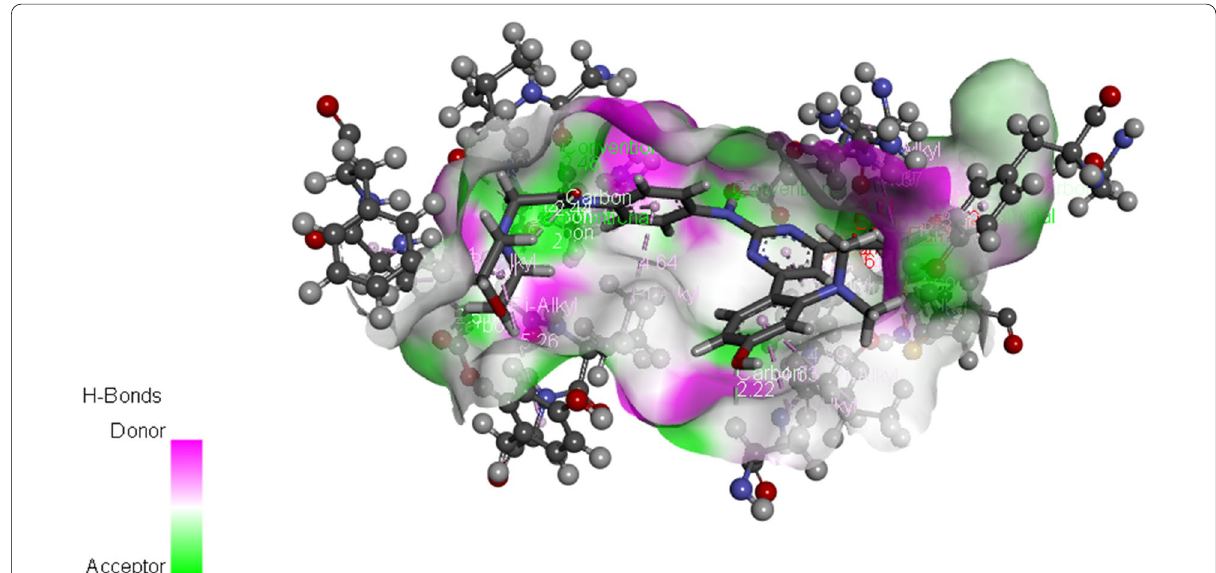
Fig. 11 3D structure of the designed compound 4 interactions with VEGFR-2 receptor